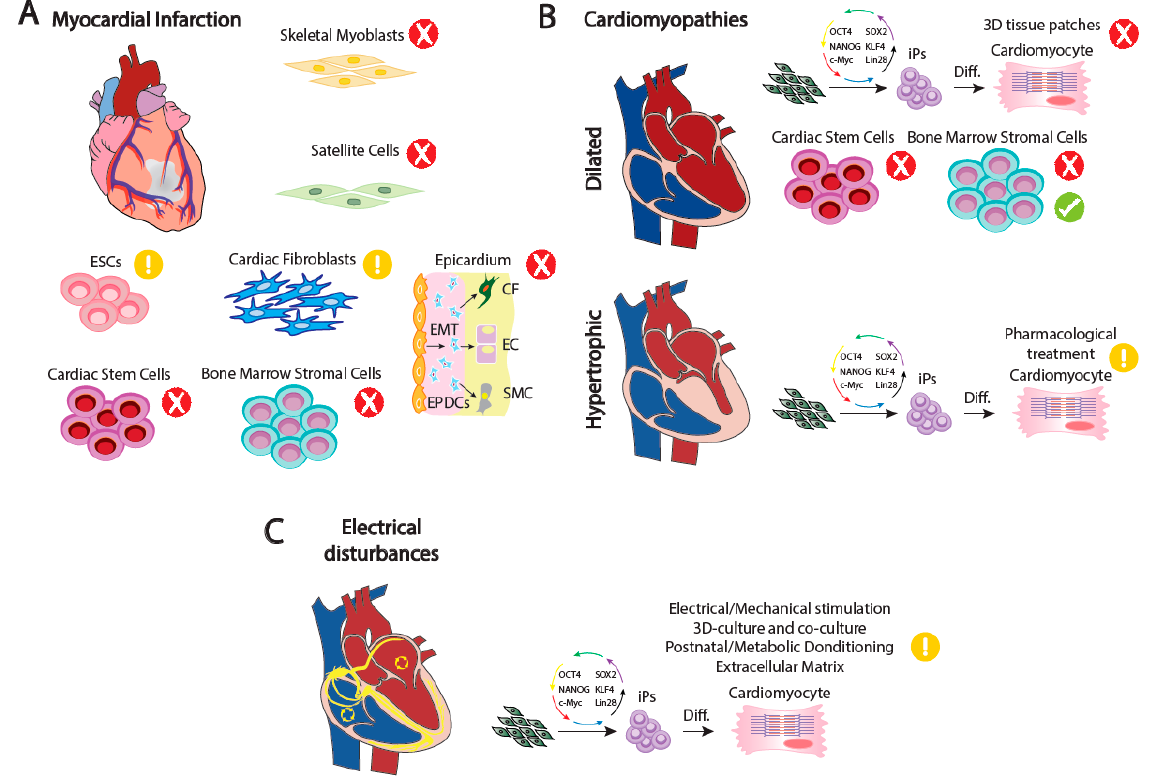
Figure 2. Schematic representation of the main adult cardiac pathologies, indicating the major advances using cell therapy to treat the damaged heart.